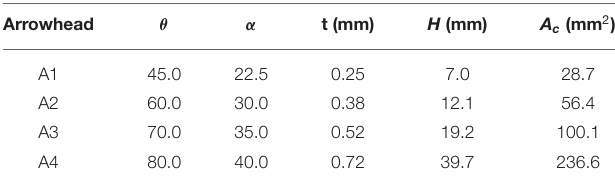
TABLE 1 | Inclination angles θ and α , thickness t , height H , and enclosed area A c values for each arrowhead unit cell type, A1–A4.